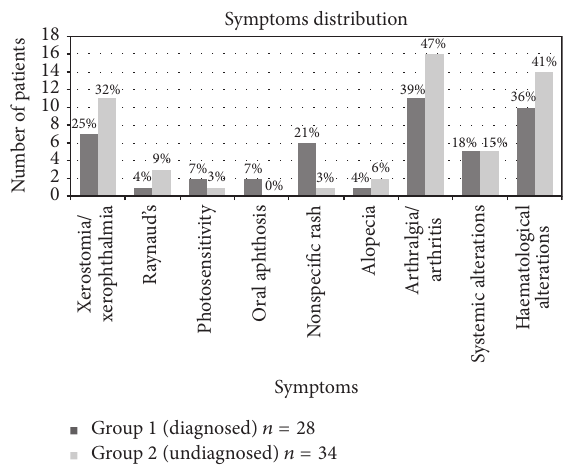
Figure 2: Distribution of symptoms in diagnosed patients and undiagnosed patients. Numbers indicate % of patients with each symptom among each